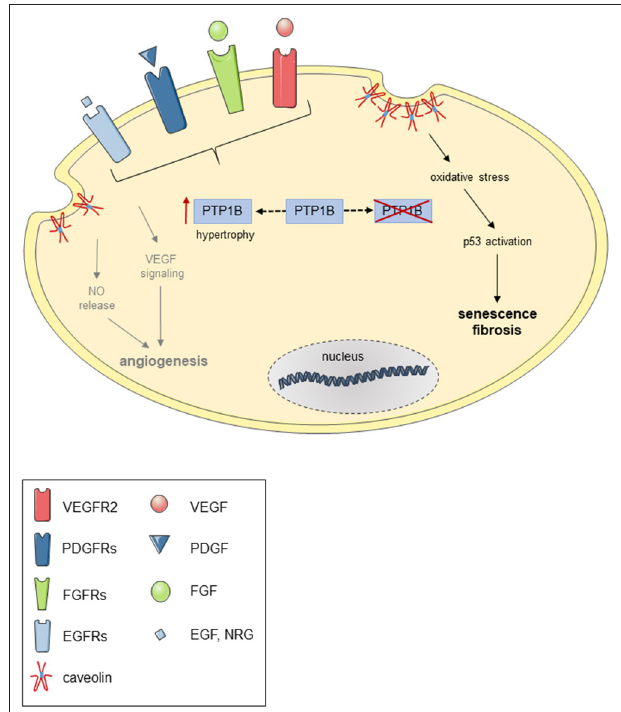
FIGURE 3 | Possible consequences of PTP1B overexpression or deletion in endothelial cells. Hypothetical scheme demonstrating possible consequence of PTP1B overexpression (e.g., during cardiac hypertrophy) and pharmacological or genetic inactivation of PTP1B in endothelial cells on receptor tyrosine kinase-mediated NO release and angiogenic signaling and oxidative stress-induced p53 activation and cellular